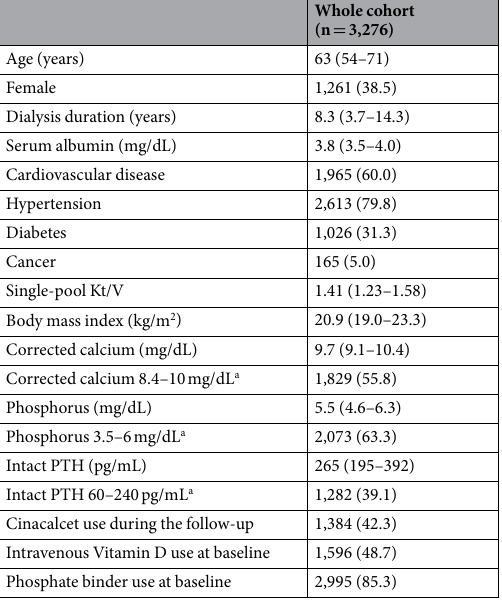
Table 1. Baseline patient characteristics. Values are presented as median (range) or n (%). a The targets of bone mineral markers used here were those outlined in the Japanese clinical guidelines. PTH, parathyroid